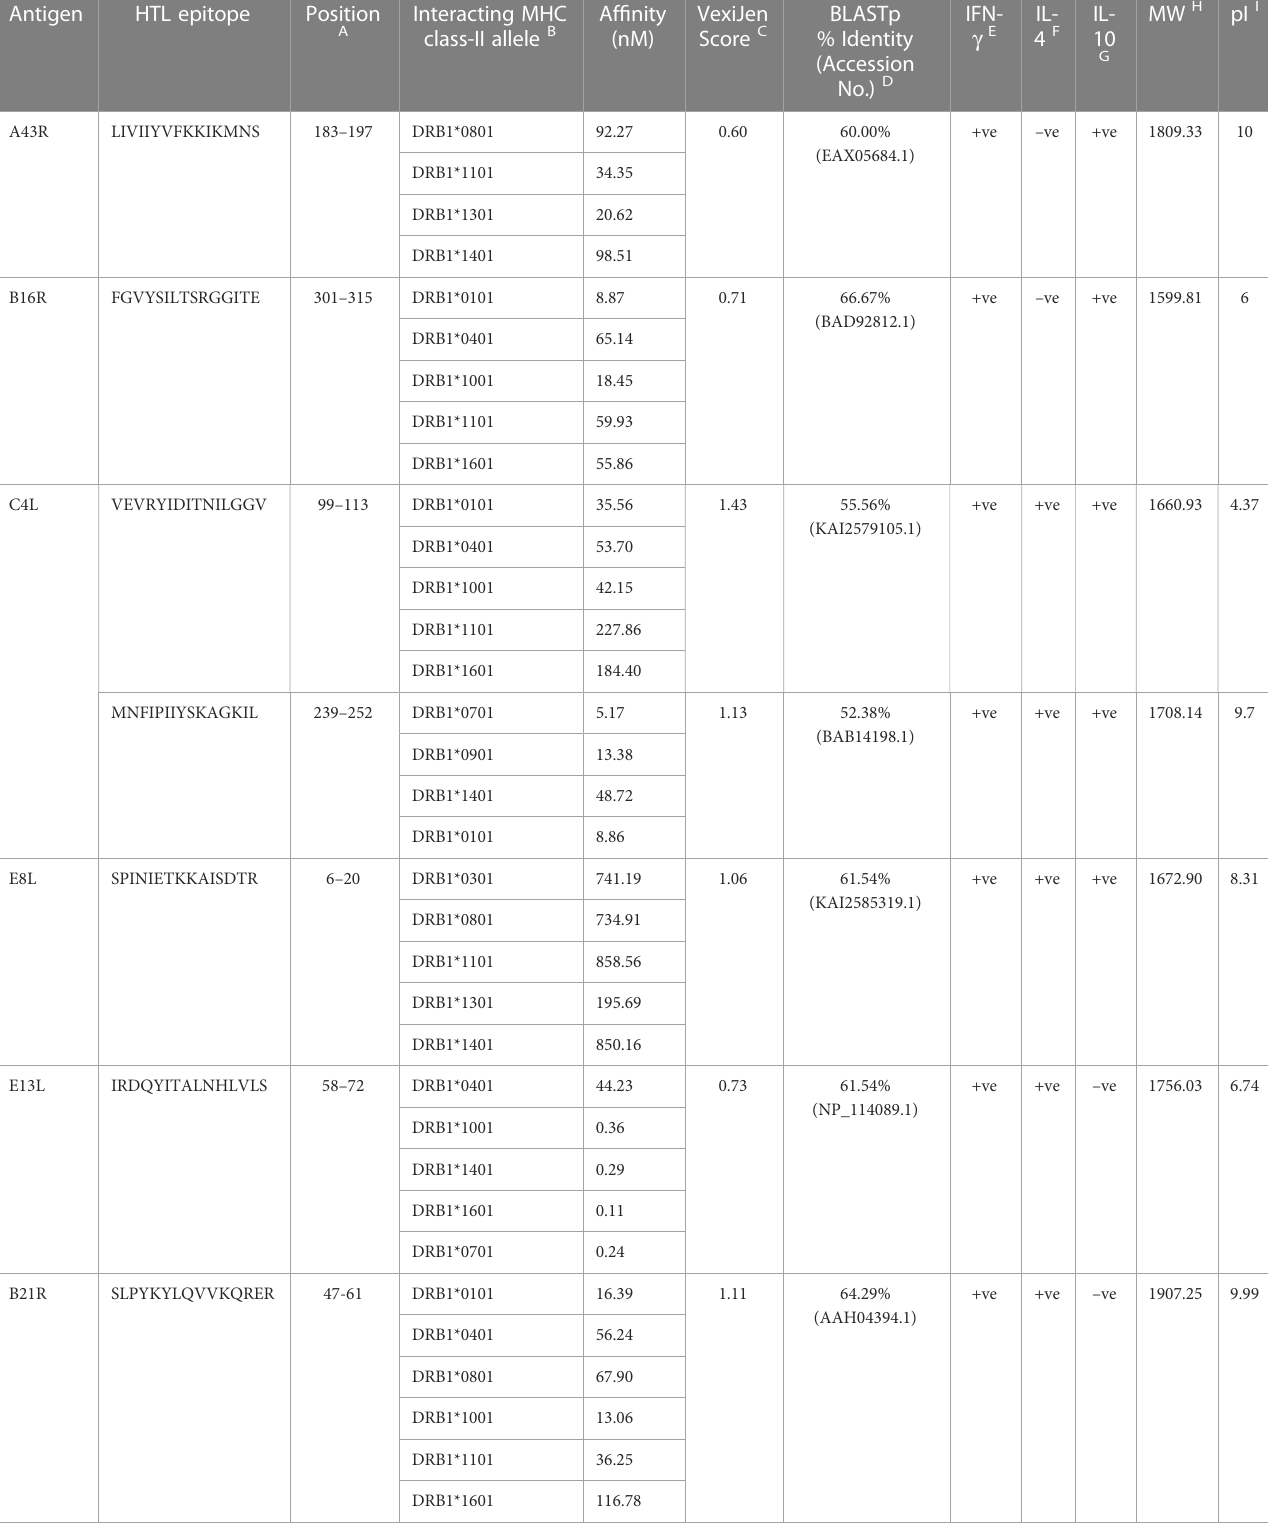
TABLE 3 Potential promiscuous HTL epitopes identi fi ed for the most frequent HLA class II alleles.